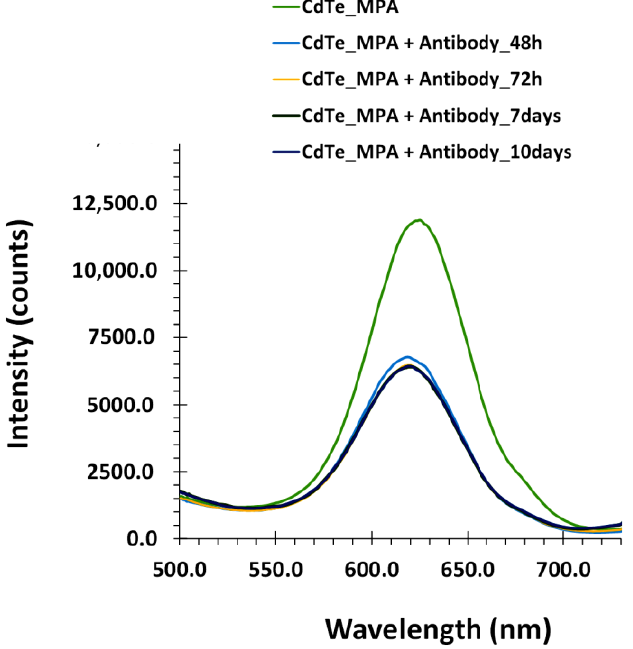
Figure 5. CdTe@MPA QD and their conjugation with CA 15-3 antibody emission spectra using a photomultiplier tube voltage of 400 PMT and an excitation wavelength of 380 nm ( n = 3). The first measurement was performed 48 h after the preparation of the system. After 72 h, the sample showed an intensity loss of 3.86%. This value remained almost the same during the stability study, varying from a signal loss of 0.13% after 7 days to a loss of 0.76% after 10 days. From these results, it can be concluded that the solutions of QD con- jugates require 72 h after their preparation to stabilize, with the initial signal remaining stable for up to 10 days. 3.3. Calibration Curve The ability of QD conjugates to show a linear response in the presence of the target protein CA 15-3 in a spiked buffer was investigated by fluorescence spectroscopy (Figure S3). The emission wavelength was set at 624.2 nm because the calibration curves showed a higher slope at this wavelength, which improved the sensitivity of this method. During the calibrations of QD conjugates with increasing concentrations of CA 15-3 protein standards prepared in PBS 10 mM at pH 7.4, the fluorescence intensity of QD con- jugates decreased, as shown in Figure S3. From these results, we concluded that recogni- tion of the CA 15-3 protein attenuates the QDs ’ fluorescence. Overall, we can conclude that the QD conjugates were able to discriminate a sample from 0.09 U/mL to 0.45 U/mL and limit of detection of 0.027 U/mL, and the low error bars show the reproducibility of the CA 15-3 biosensor developed in this work. Next, the device was tested in 10-fold diluted spiked human serum in PBS 10 mM at pH 7.4. Initially, the calibrations were performed in undiluted human serum, but the highly concentrated and complex human serum matrix promoted fluorescence attenua- tion of the red-emitting QDs, resulting in a conditioned response of the CA 15-3 biosensor. For this reason, human serum was first filtered to remove positively charged salts that affect the fluorescence of the QDs and, consequently, the stability of the biosensor. This pretreatment also removed smaller molecules such as glucose and smaller proteins. The correspondent fluorescence emission spectra are presented in Figure 6.